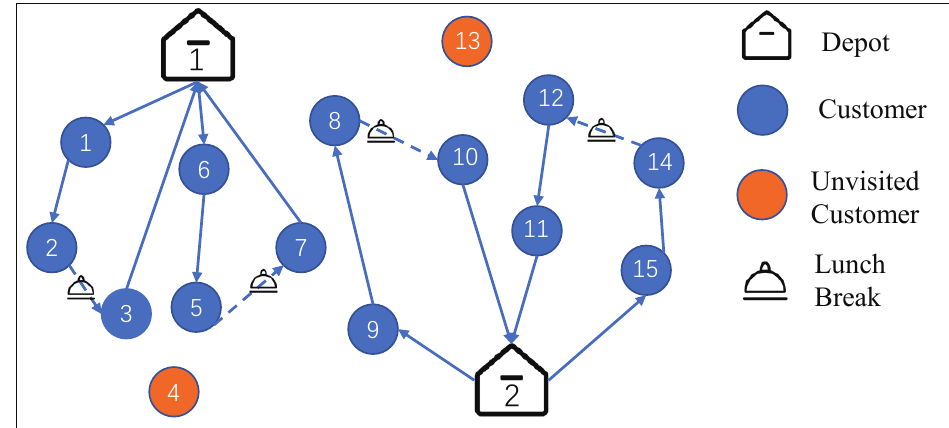
Figure 1. Feasible solution for an